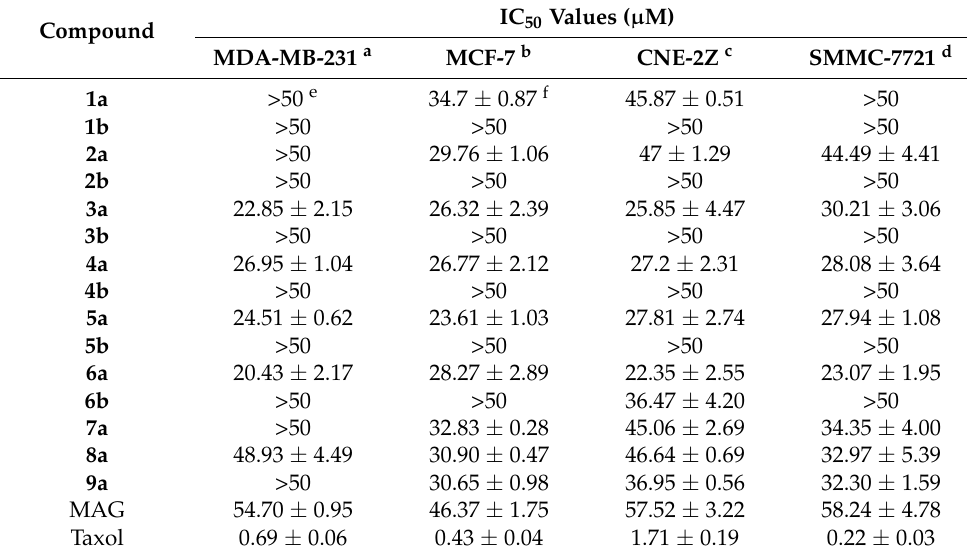
Table 1. Cytotoxic activity of magnolol derivatives (IC 50 , µ M, 72